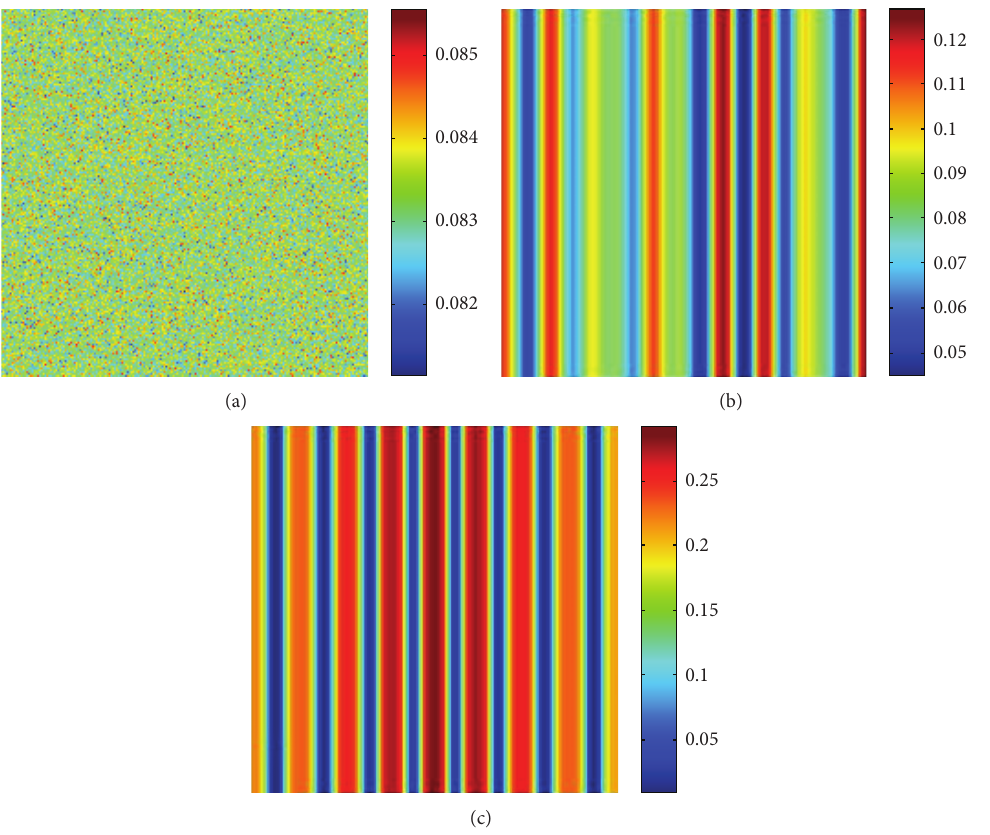
Figure 8: Snapshots of contour diagrams of the time evolution of algae at different points in time with 𝑁 = 0.25, 𝐷 2 = 0.5, V = 2 . (a) 0 iterations, (b) 50000 iterations, and (c) 100000